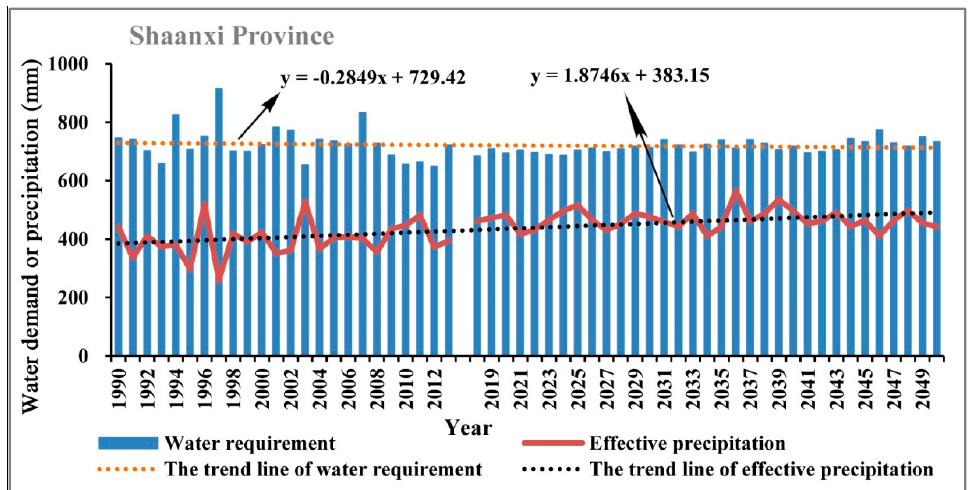
Figure 11. The changing trend of the water demand of apple trees and the effective precipitation in Shaanxi Province in the periods of 1990–2013 and 2019–2050.